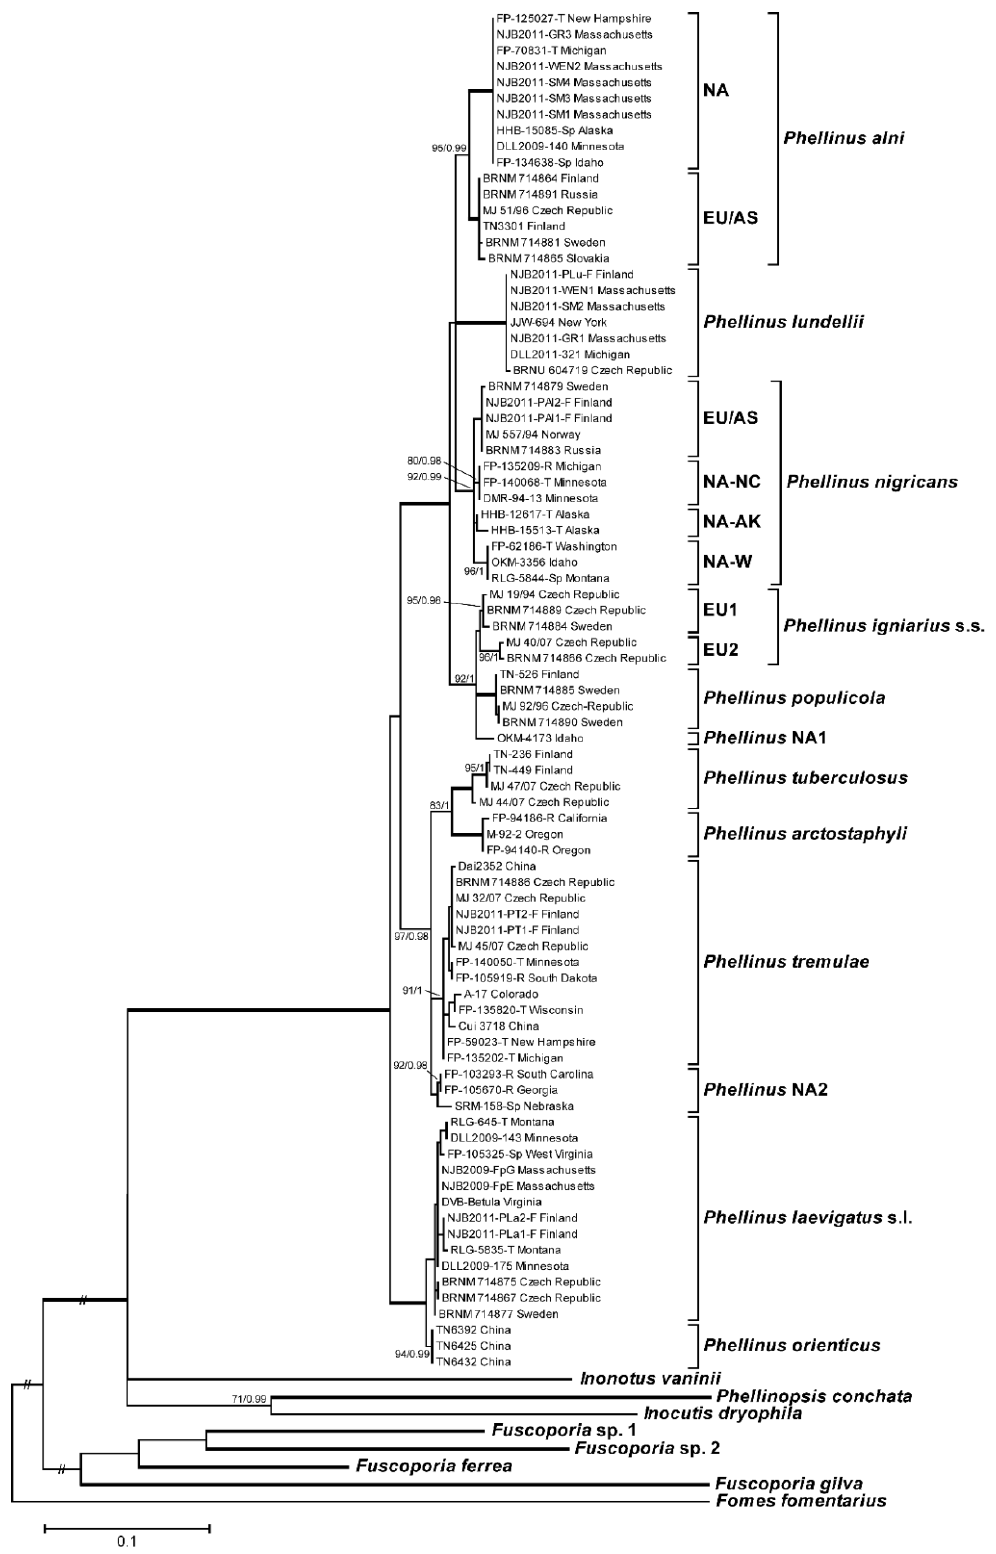
Figure 1. Maximum likelihood tree based on rDNA ITS sequences of Phellinus s.s. species. Bootstrap support values ≥70% and PP values ≥0.95 are shown next to the nodes. Thickened branches represent BS/PP values ≥99%/1. Intraspecific variation by geographic origin is defined by the following codes: NA, North America; EU, Europe; AS, Asia; NA-NC, north-central North America; NA-AK, Alaska; NA-W, western North